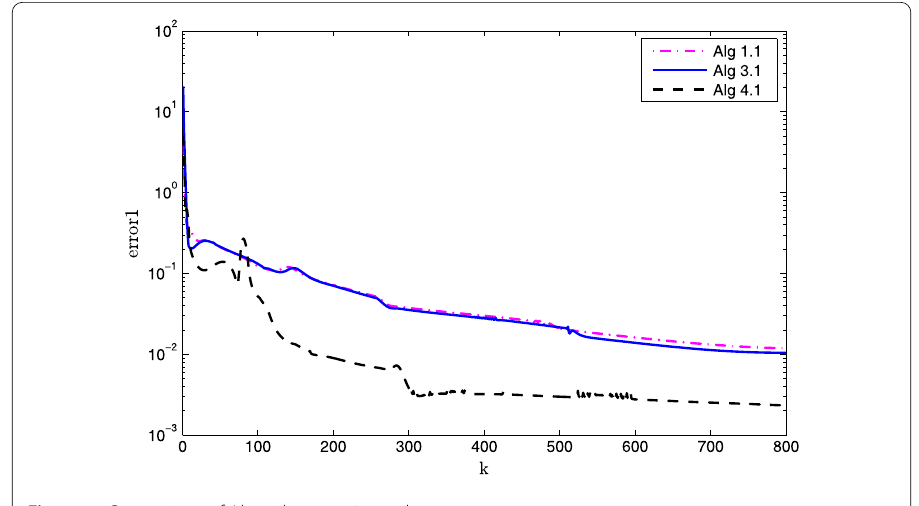
Figure 1 Comparison of Algorithms 1.1, 3.1 and 4.1